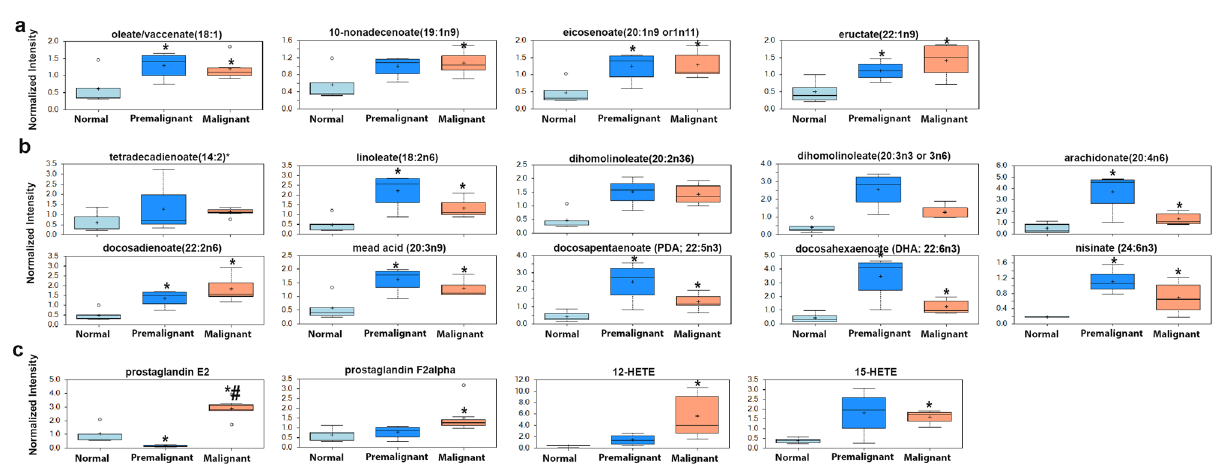
Figure 5. Enrichment of ( a ) long chain fatty acids (LCFA), ( b ) poly-unsaturated fatty acids (PUFA) , and ( c ) eicosanoids in normal, premalignant, and early malignant urothelial lesions. * p < 0.05 compared to normal. # p < 0.05 comparing premalignant to malignant lesions, one-way ANOVA with multiple